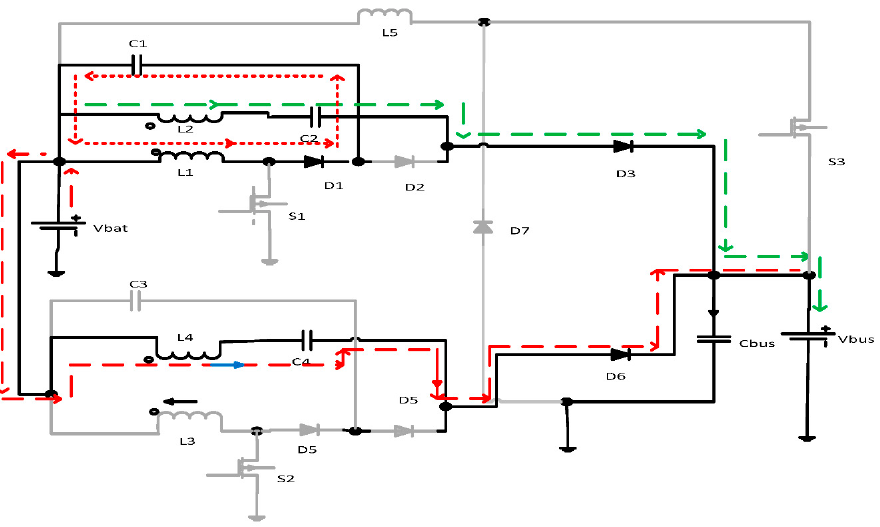
Figure 9. Mode III of operation.